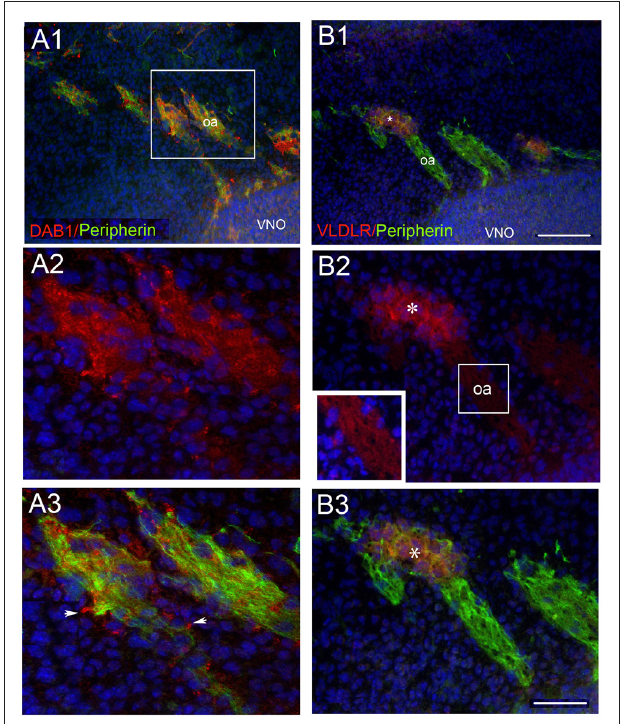
FIGURE 5 | Olfactory sensory neurons express Dab1 and VLDLR during mouse embryonic development. Sagittal sections of E14.5 mice immunostained with indicated antibodies. Olfactory axons identified by antibodies to peripherin (green). Dab1 ( A1–A3 , red), if expressed on olfactory axons, was at a level much lower than that of surrounding OECs and GnRH cells ( A3 , red structures still detected, white arrowheads). VLDLR expression (B1–B3) was detected on the axonal tracks ( B2 inset), but also at a level lower than that of surrounding OECs and GnRH cells (Large cluster of VLDLR positive migratory cells is indicated by asterisk). Scale bar in (B1) = 25 µ m (same in A1 ). Scale bar in (B3) = 50 µ m (same in A1,A2,B1